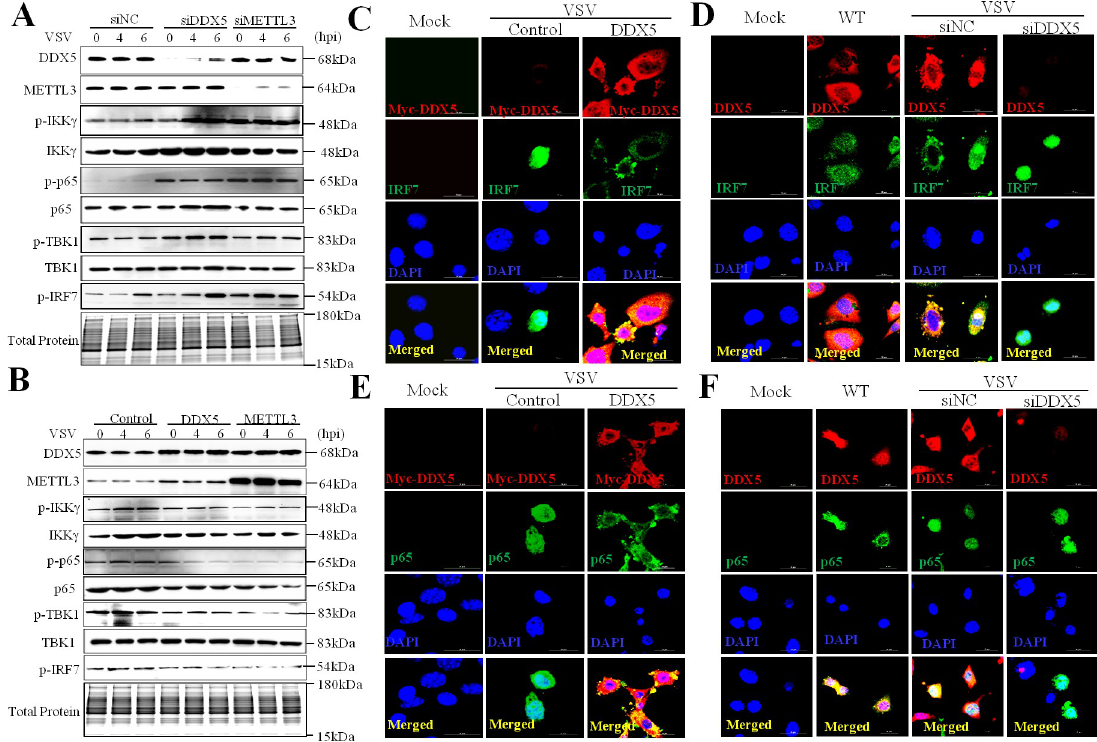
Fig 7. DDX5 negatively regulated DHX58-mediated TBK1 and p65 pathways in innate immunity. (A, B): Immunoblot of DHX58-mediated TBK1 and p65 pathways in DDX5-knockdown MEFs (A) or DDX5-expressing MEFs (B). MEFs were transfected with DDX5 siRNA or METTL3 siRNA (siNC) for 48 h (A), or with DDX5 or METTL3 expression (control vector) for 24 h (B); then, cells were infected with VSV for 0, 4, and 6h, lysed, and collected to detect DDX5, METTL3, p-IKK γ , IKK γ ,p-p65,p65,p-TBK1, TBK1 and p-IRF7 via western blot. (C, D): Nuclear transfer of IRF7 was observed by IFA and CLSM. MEFs were transfected with DDX5-expression plasmids (control vector) for 24 h (C) or with DDX5 siRNA (siNC) for 48 h (D), infected with VSV for 8 h, and then subjected to IFA with anti-IRF7 monoclonal antibody followed by Alexa Fluor 488 F(ab 0 )2 fragment of goat anti-mouse IgG (H+L). Nuclei were stained with DAPI. Normal MEFs (WT) were used as the control. Slices were observed by LSCM. Scale bars, 20 μ m. (E, F): Nuclear transfer of p65 observed by IFA and CLSM. MEFs were transfected with DDX5-expression plasmids (E) or with DDX5 siRNA (F), infected with VSV for 8h, and subjected to IFA with anti-p65 monoclonal antibody followed by Alexa Fluor 488 F (ab 0 )2 fragment of goat anti-mouse IgG (H+L). Nuclei were stained with DAPI. Normal MEFs (WT) were used as the control. Slices were observed by LSCM. Scale bars, 20 μ m. (Fig 7D and 7F). Taken together, DDX5 thwarts DHX58-TBK1 and p65 pathways in innate immunity.